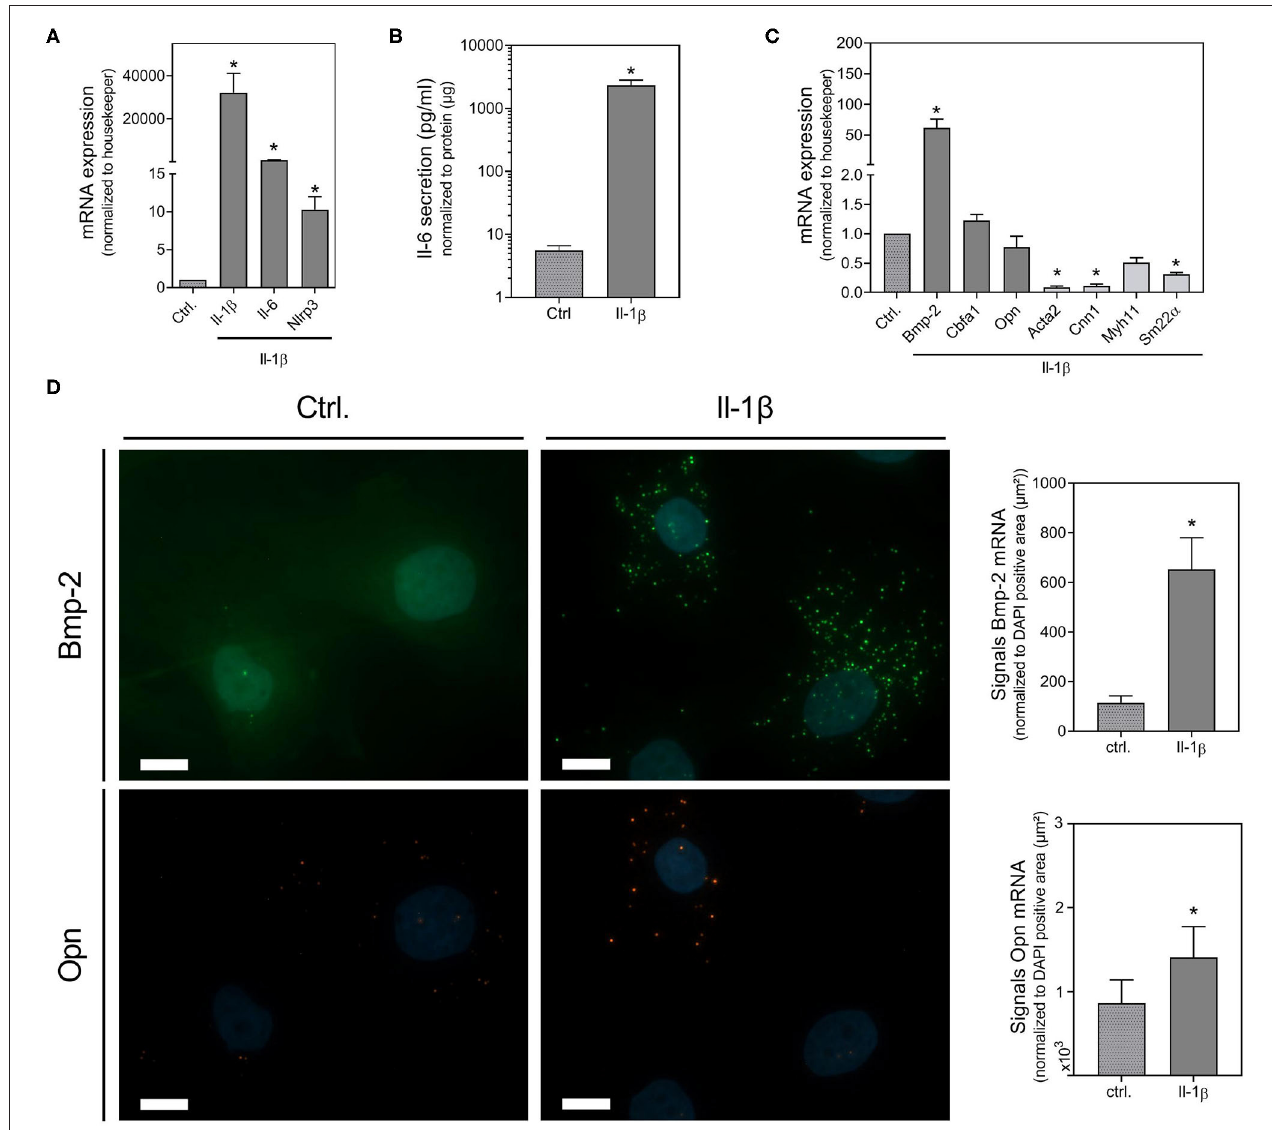
FIGURE 4 | Il-1 β induced changes in osteoblastic and pro-inflammatory gene expression and protein secretion. VSMCs were stimulated for 48h with 100ng/ml Il-1 β . mRNA expression was measured with quantitative real-time PCR (A,C) . Measured thresholds of the respective targets were normalized to the corresponding average threshold of housekeeper genes actin and Gapdh before normalization to control (A,C) . Secretion of Il-6 was measured with Luminex TM and normalized to protein content ( µ g) (B) . Expression of Bmp-2, Opn were visualized with RNA in situ hybridization staining and were quantified by counting signal dots per whole image, normalized to the DAPI positive cell core area per image ( µ m 2 ) (D) . Data represent mean ± SEM, n ≥ 3, * p < 0.05 vs. control, pictures show a section of a representative experiment of n ≥ 3, the scale bar indicates a 10 µ m section (D) . Full representative images are shown in Supplementary Table 4